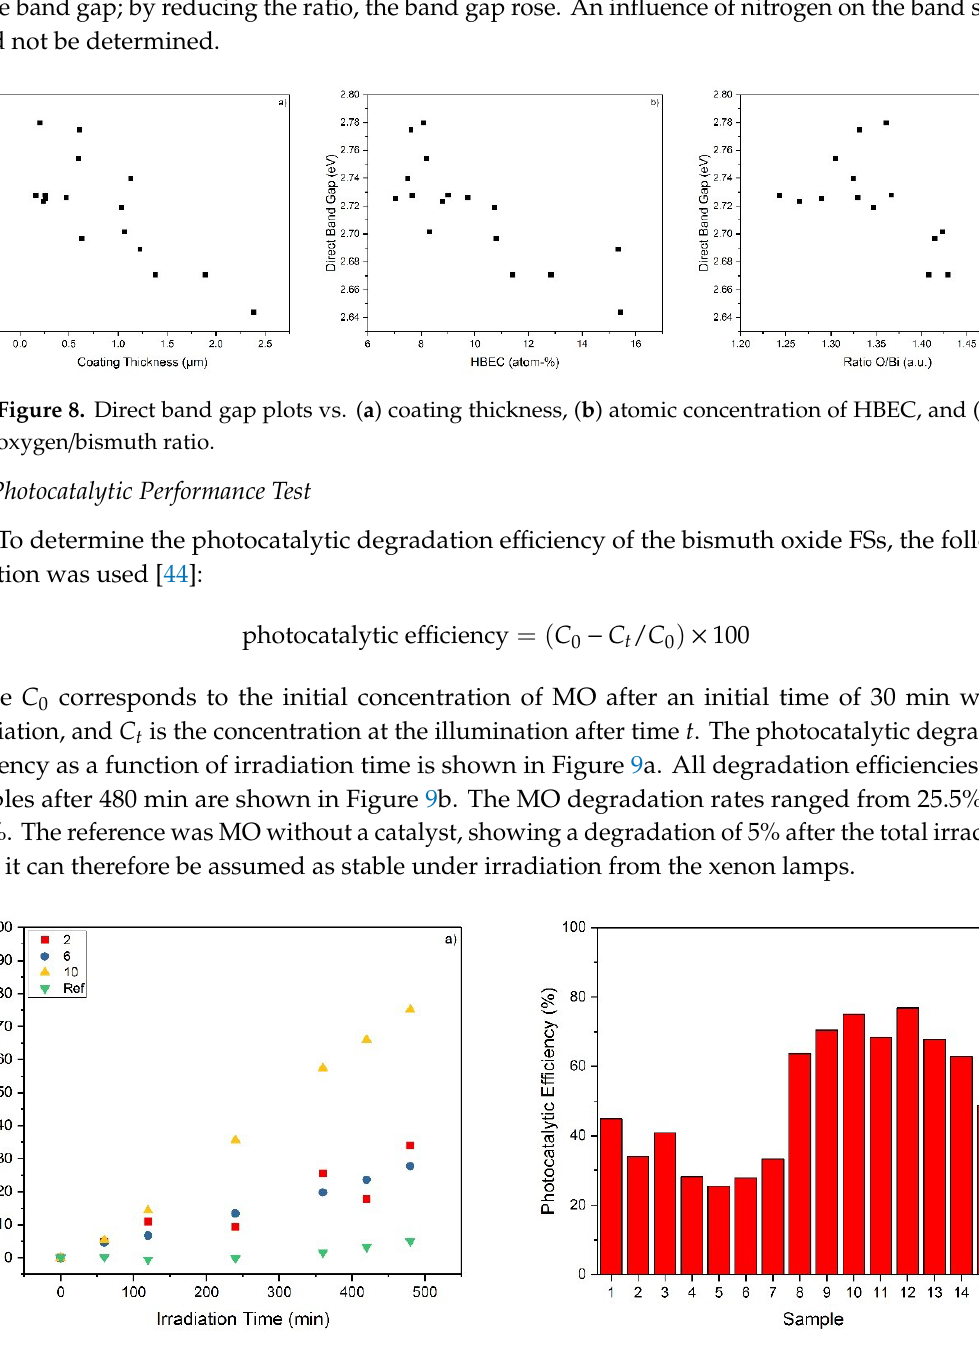
Figure 9. ( a ) Photocatalytic efficiency as a function of irradiation time, and ( b ) degradation efficiencies of coatings.